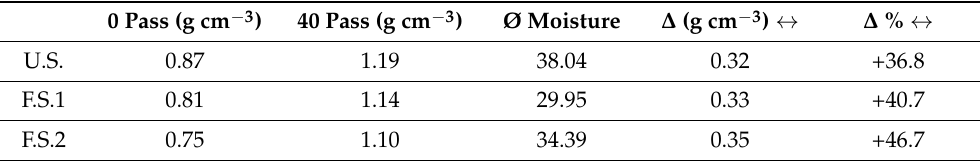
Table 5. Comparison of initial and final bulk densities (g cm − 3 ) at the experimental plots subjected to traffic by particular machines; U.S.—universal skidder Zetor 7245, F.S.1—forest skidder LKT 81 ITL, F.S.2—forest skidder HSM 805 HD .